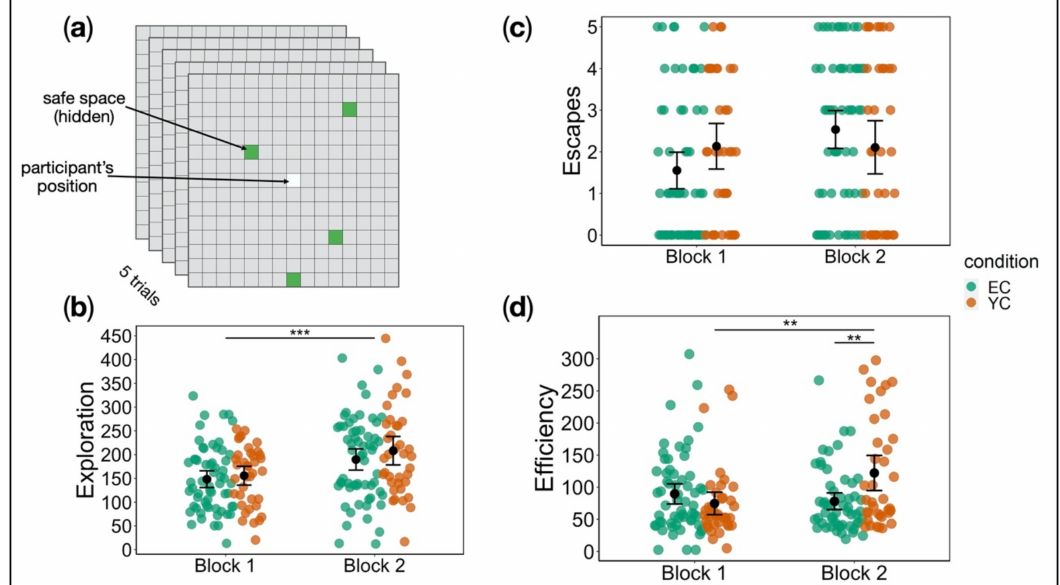
Figure 3. ( a ) Escape behaviour test (one block). ( b ) Exploration during the stress-free phase in the escape behaviour test by group and block. Both groups explored more in block 2 compared to block 1; we observed no interaction e ff ects. ( c ) Escapes from stress in the escape behaviour test by group and block. EC escaped the stressor more often in block 2 compared to block 1, whereas no such improvement was evident in YC. Despite that, the interaction of group x block did not survive family-wise error correction. ( d ) Interaction e ff ect of group x block on e ffi ciency in the escape behaviour test. Whereas EC and YC did not di ff er in e ffi ciency in block 1, YC showed significantly less e ffi cient behaviour (higher scores) in block 2 compared to EC. Error bars denote standard error. Only significant e ff ects are indicated (* p < 0.05, ** p < 0.01, *** p <